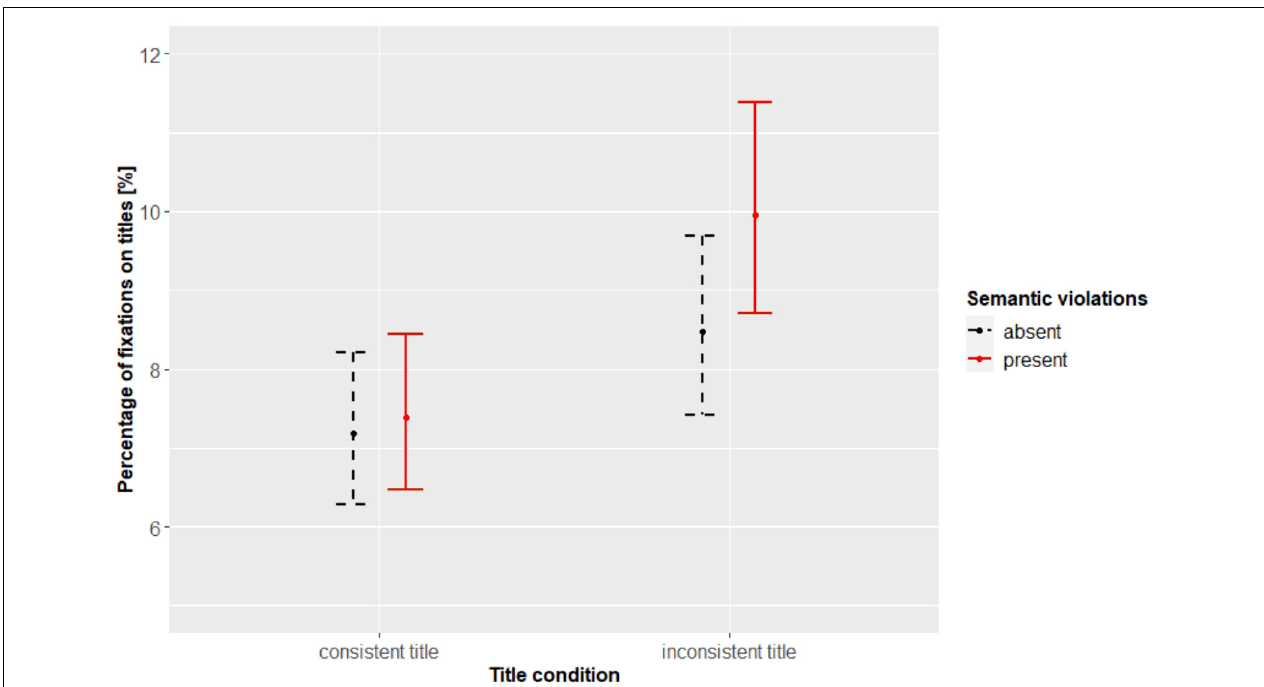
FIGURE 4 | Percentage of fixations on titles depending on the presence of semantic violations and types of titles. The error bars represent 95% confidence